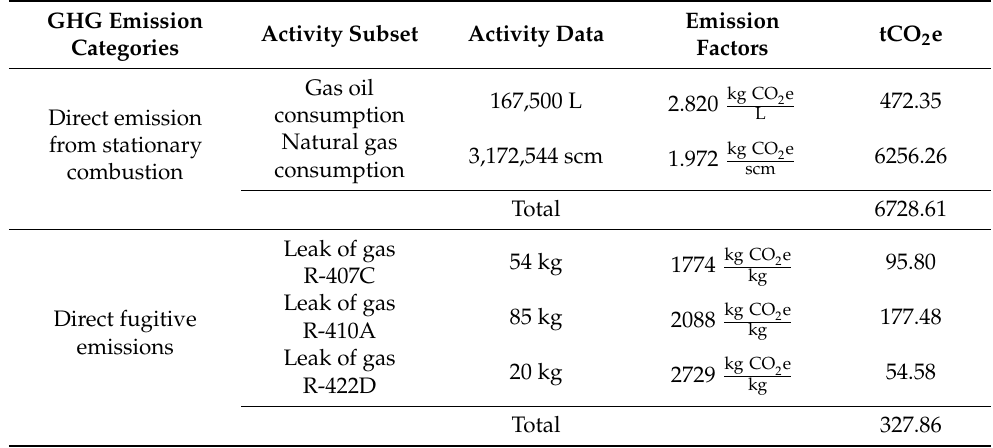
Table 4. Emissions from GHG categories of Scope 1.